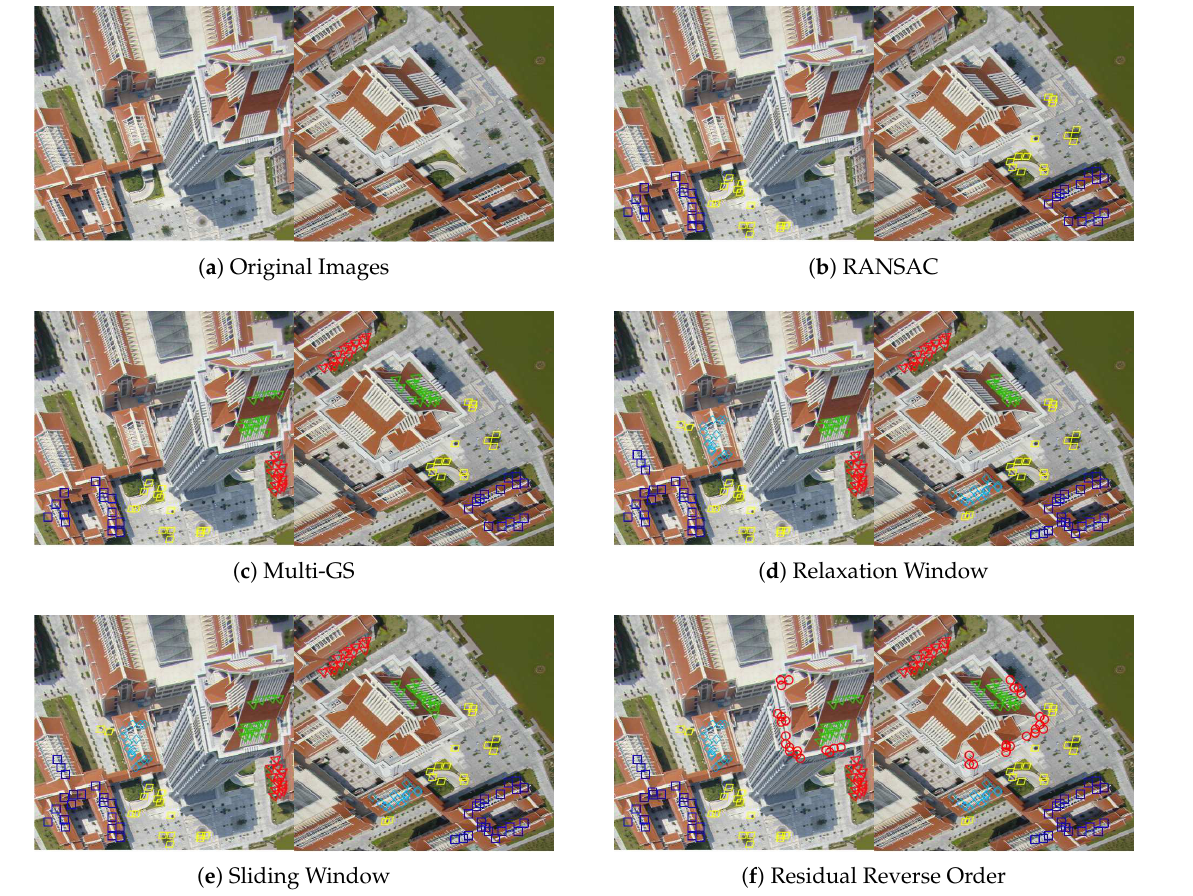
Figure 7. The six-homographic matrices extracted from Library , where green triangles, blue squares, red circles, indigo diamonds, yellow parallelograms, and red triangles respectively represent inliers (correct matched features) that located on different planes in the